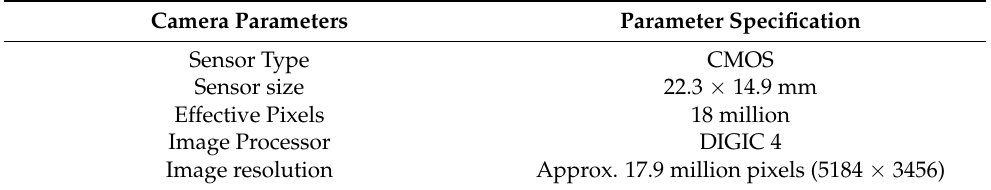
Table 1. Camera Table 1. Camera parameters.